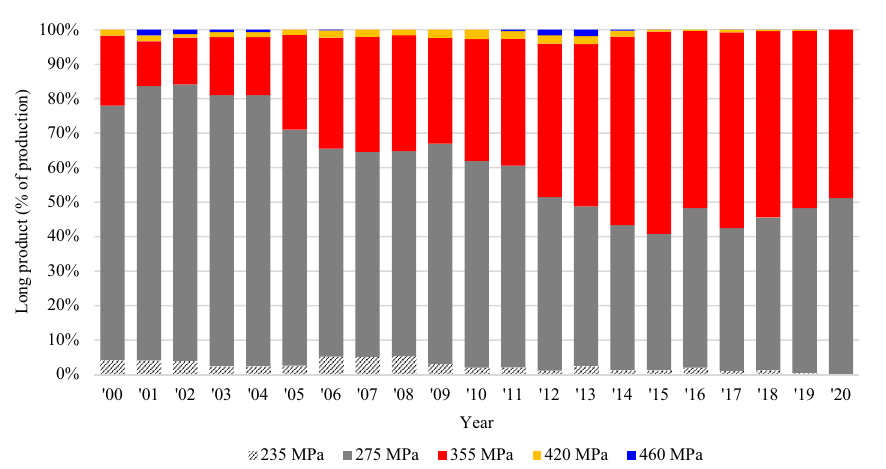
Figure 1. Analysis of long product sales trends.